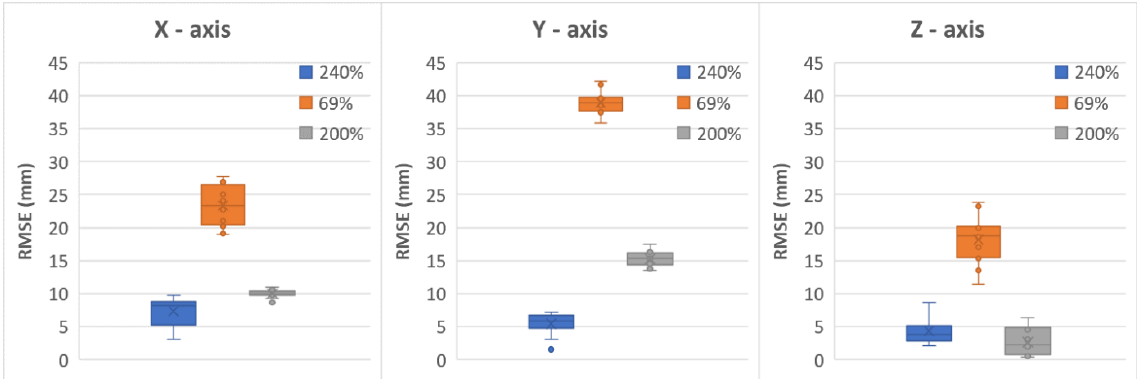
Figure 4. The RMSE values for x, y, and z axes and for individual plots, % represents recorded images percentage from recommended number of images, x symbol represents the mean, horizontal line median, vertical lines depict 1st and 4th quartiles, and boxes contain 2nd and 3rd quantiles divided by median lines.